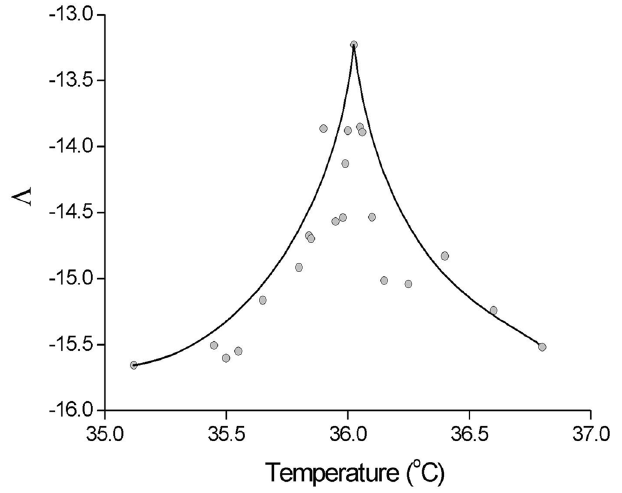
Figure 2. Dynamic range of the maximal Lyapunov exponent (Λ) as a function of temperature at criticality. Both sides interpolated separately by cubic splines. Compare with theoretical predictions in Fig. 2d in Ref. 8